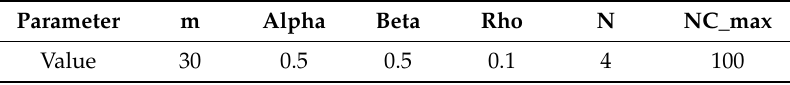
Table 3. Parameters of the ant colony clustering algorithm.